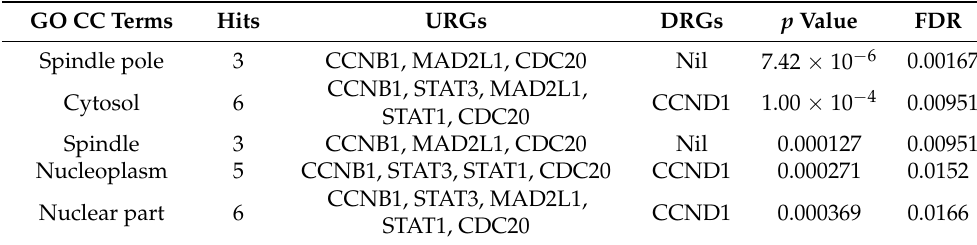
Table 3. Annotation of hub genes in GO